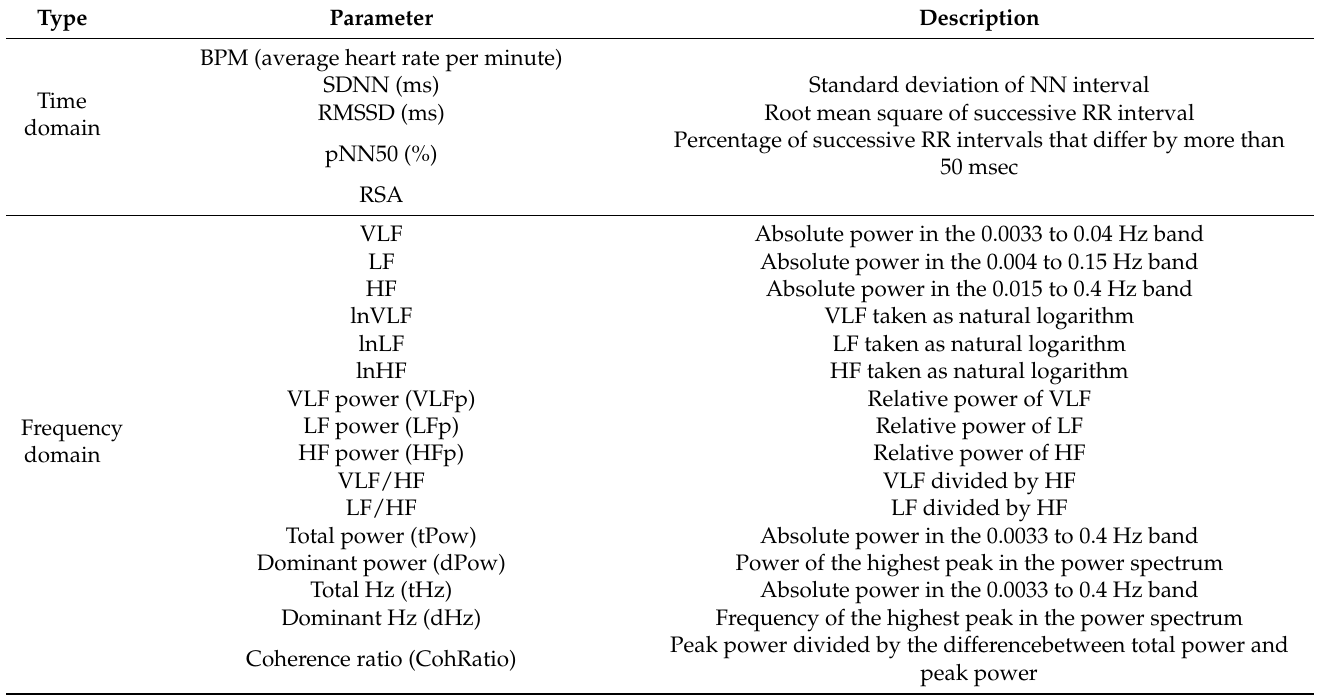
Table 6. Heart rate variability